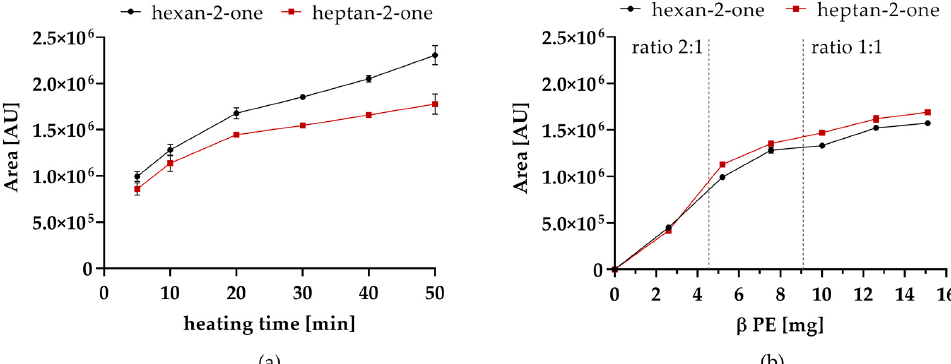
Figure 2. ( a ) Formation of hexan-2-one and heptan-2-one from 0.05% deca-2,4-dienal and PE (5 mg) at 160 ◦ C; ( b ) Formation of hexan-2-one and heptan-2-one at 160 ◦ C and 10 min treatment; 0.2% deca-2,4-dienal with varying levels of PE from a ratio of 3.5:1 up to